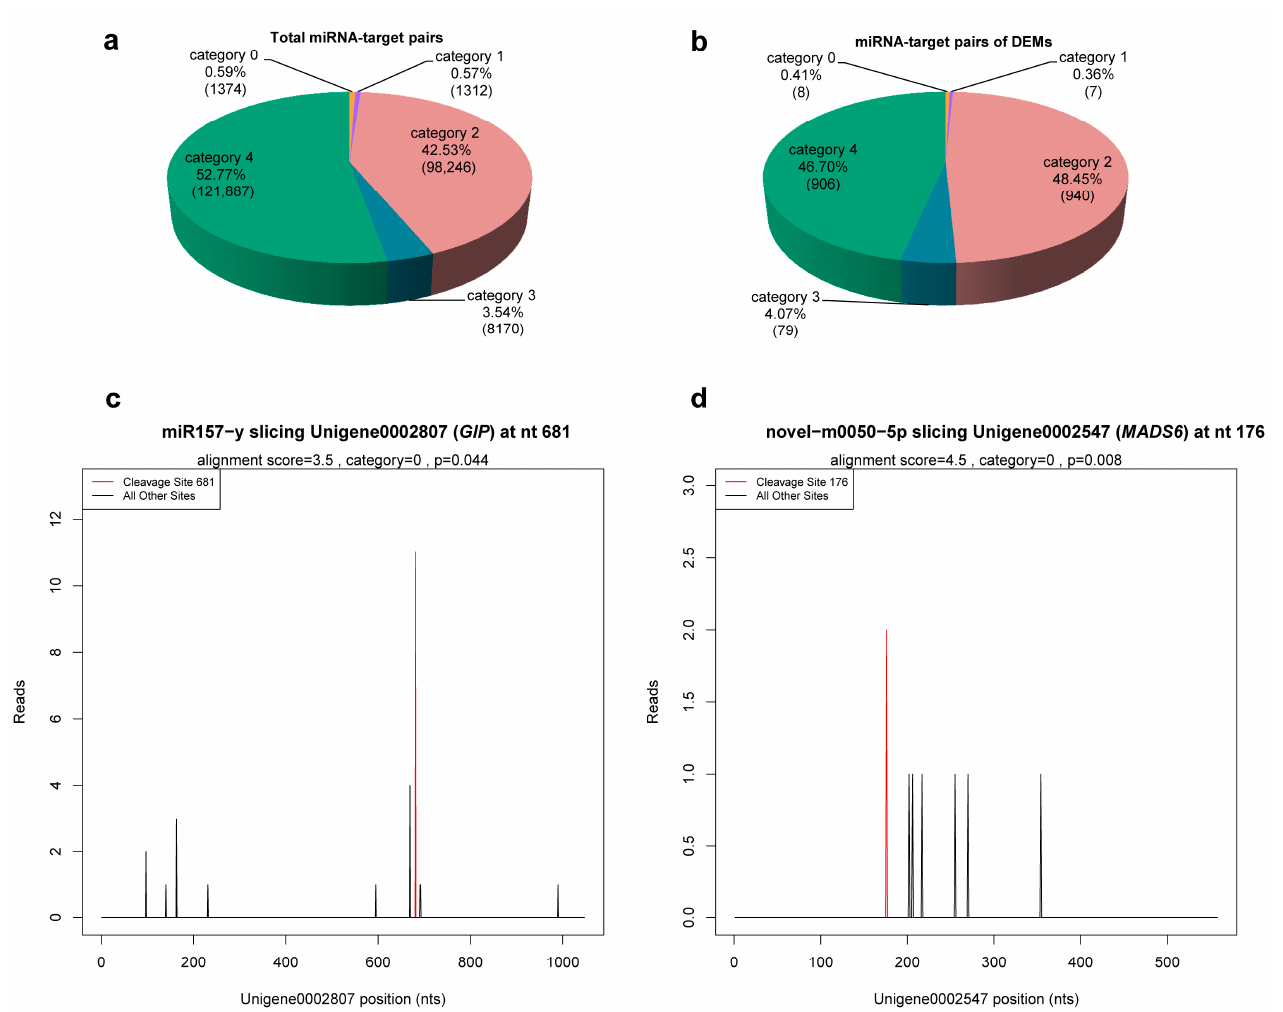
Figure 4. miRNA–target pairs. ( a , b ) Classification statistics of miRNA–target pairs. Numbers in parentheses indicate number of miRNA–target pairs. ( c , d ) The T-plots of two target genes con- firmed by degradome sequencing. The T-plots were completed with CleaveLand 3.0.